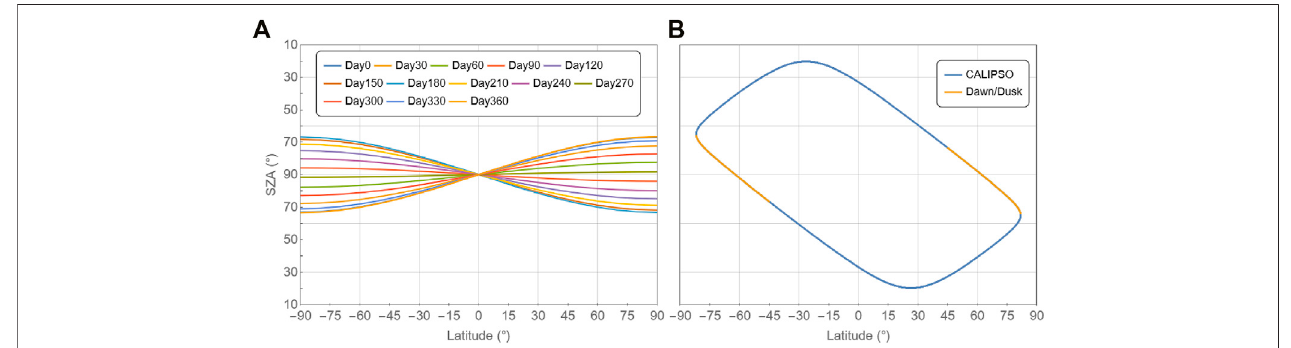
FIGURE 1 | (A) Solar zenith angle as a function of latitude and Julian day of the year for the dawn/dusk orbit envisioned for the thermodynamics lidar. (B) SZA vs latitudefortheCALIPSOorbitof15July2009(blueandorange)withtheselectionoftheportionoftheorbitcharacterizedbySZAvaluescorrespondingtothedawn/dusk orbit shown (orange).